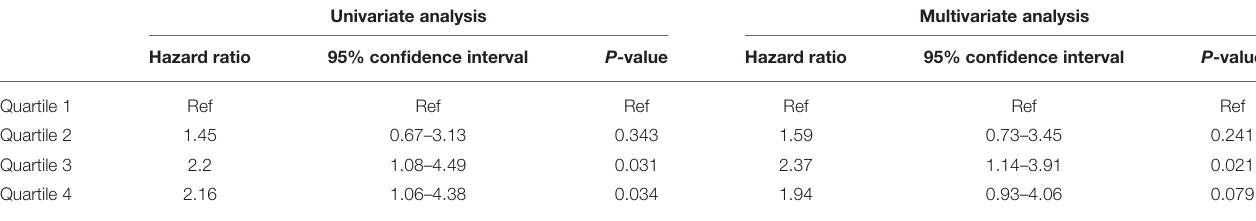
TABLE 5 | Association between TWA quartiles of Mg and all-cause mortality by univariate and multivariate